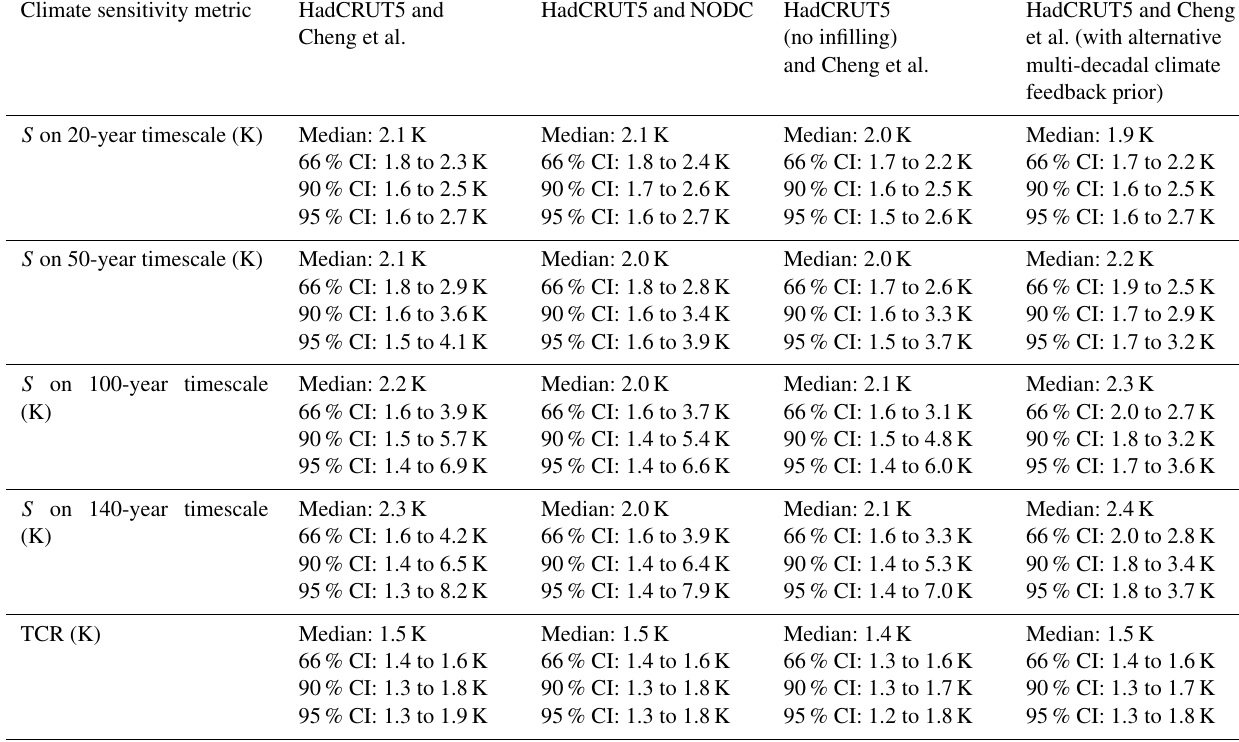
Table 1. Climate sensitivity ( S , K) and transient climate response (TCR, K) best estimate (median) and ranges (where 66% confidence interval represents the 17th to 83rd percentile range, 90% confidence interval represents 5th to 95th percentile range, and 95% confidence interval represents 2.5th to 97.5th percentile range) under different observational constraints for surface warming and heat uptake. All ensembles use the standard prior distributions (Table S1) except “HadCRUT5 and Cheng et al. (with alternative multi-decadal climate feedback prior)”, which uses the prior for λ multi-decadal from Sherwood et al. (2020) (Fig. 8c, purple) and standard priors for all other terms. Climate sensitivity metric HadCRUT5 and Cheng et